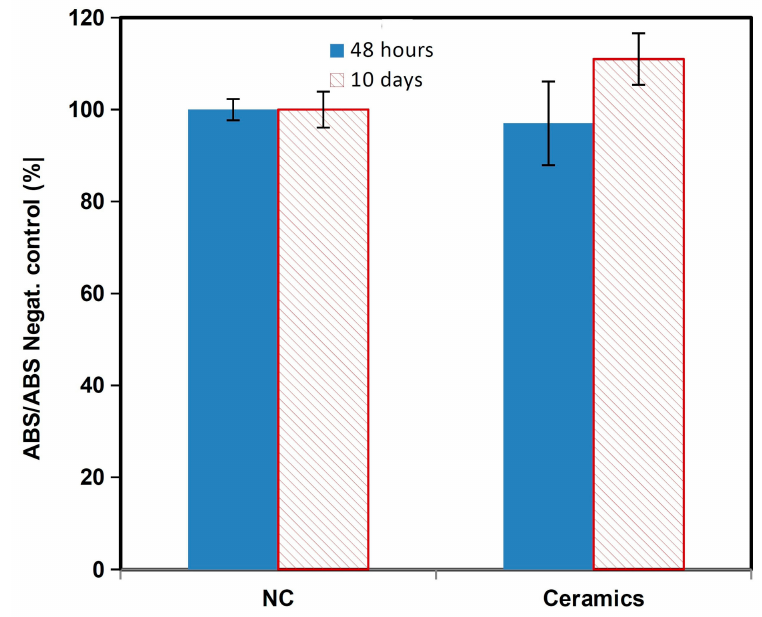
Figure 5. MTS cytotoxicity of the